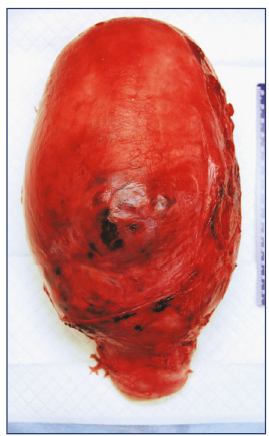
Figure 2: Intact hysterectomy specimen. Anterior wall demon- strates softened tumescence, with patchy hemorrhagic and con- gested